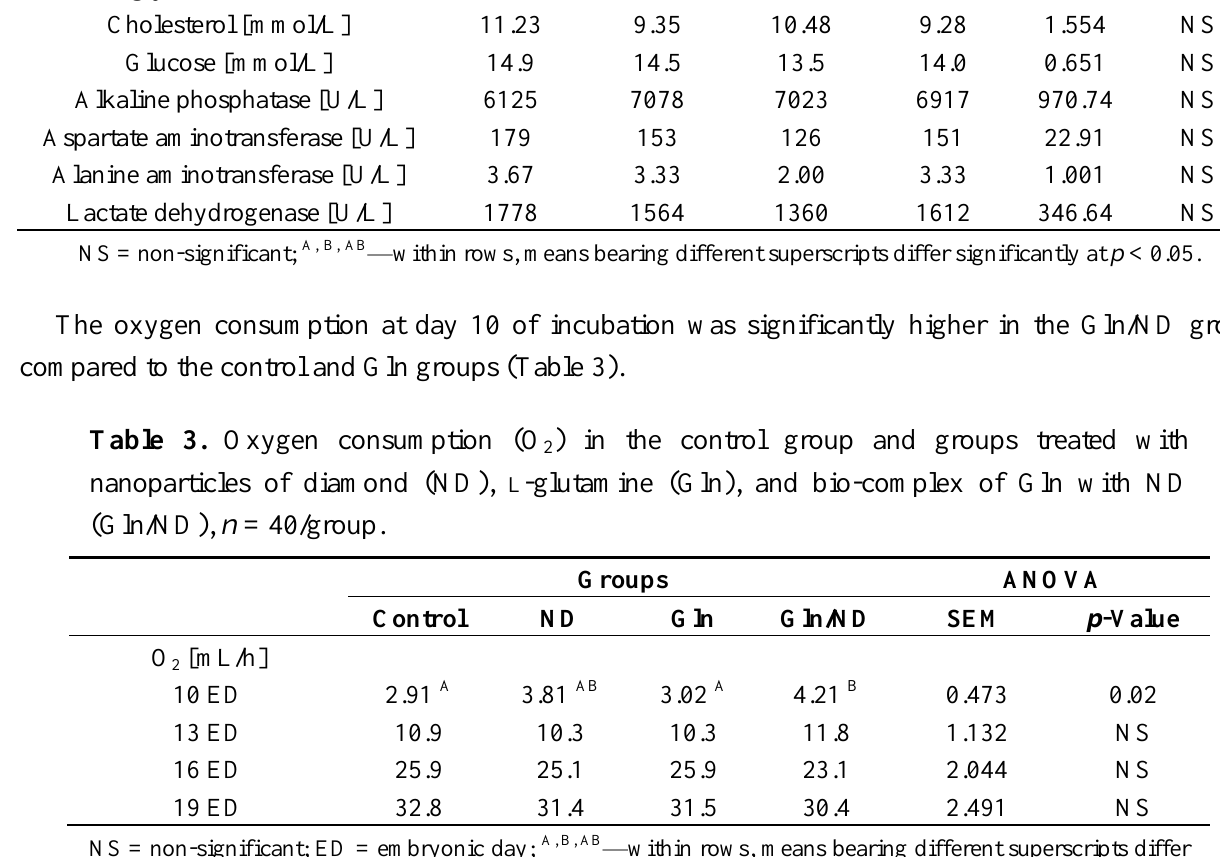
Table 2. Biochemical indices in the blood serum of 20-day-old chicken embryos in the control group and groups treated with nanoparticles of diamond (ND), L -glutamine (Gln), and bio-complex of Gln with ND (Gln/ND), n = 40/group. Groups ANOVA Control ND Gln Gln/ND SEM p -Value Magnesium [mmol/L] 0.87